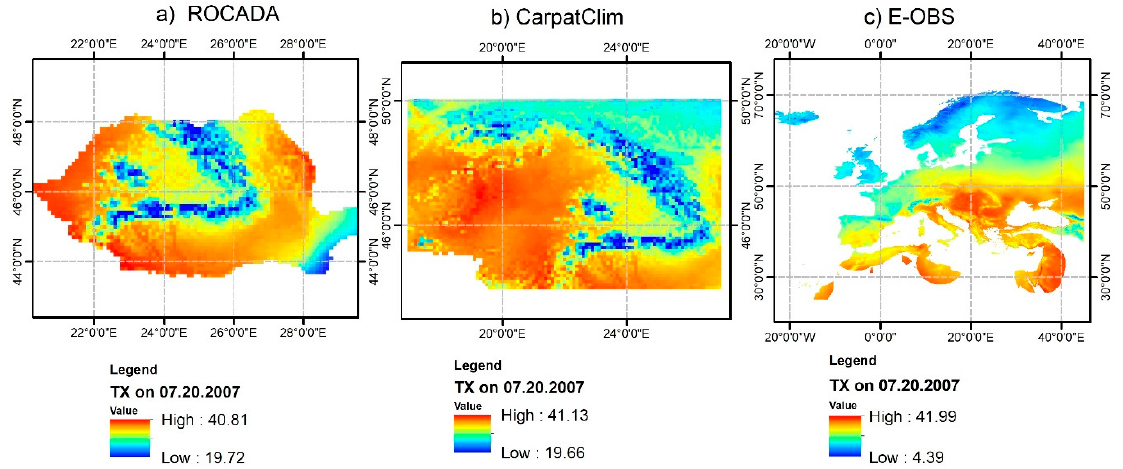
Figure 2. Spatial domains for the databases used in this